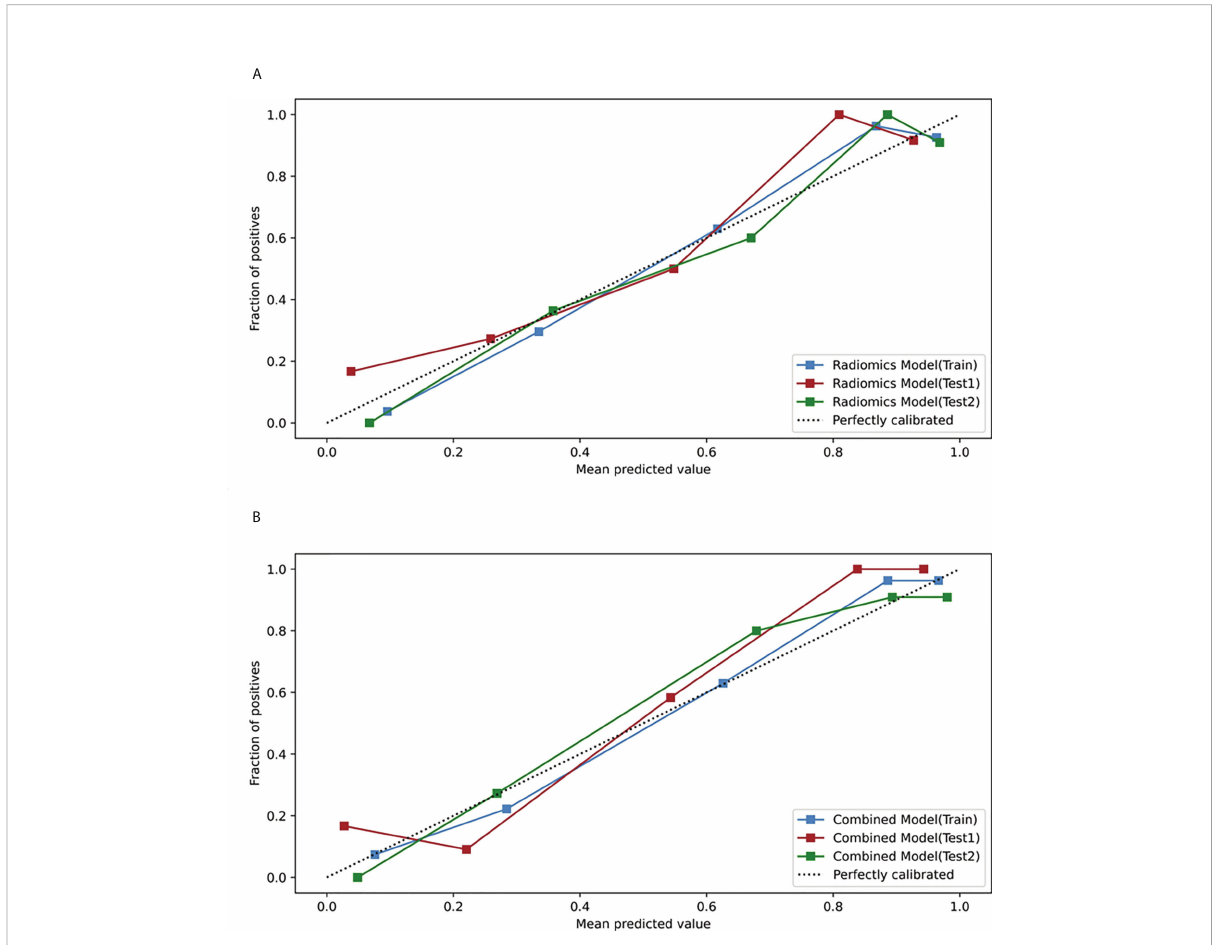
FIGURE 7 Calibration curves of the radiomics model and the combined model in the training, test 1 and test 2 sets. (A) Calibration curves of the radiomics model (T2WI+SVM). (B) Calibration curves of the combined